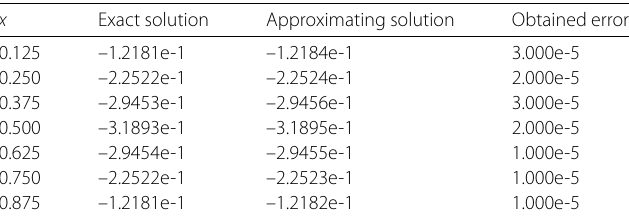
Table 6 Comparison of solutions obtained by the presented method with the exact solution of Example 3 while n =